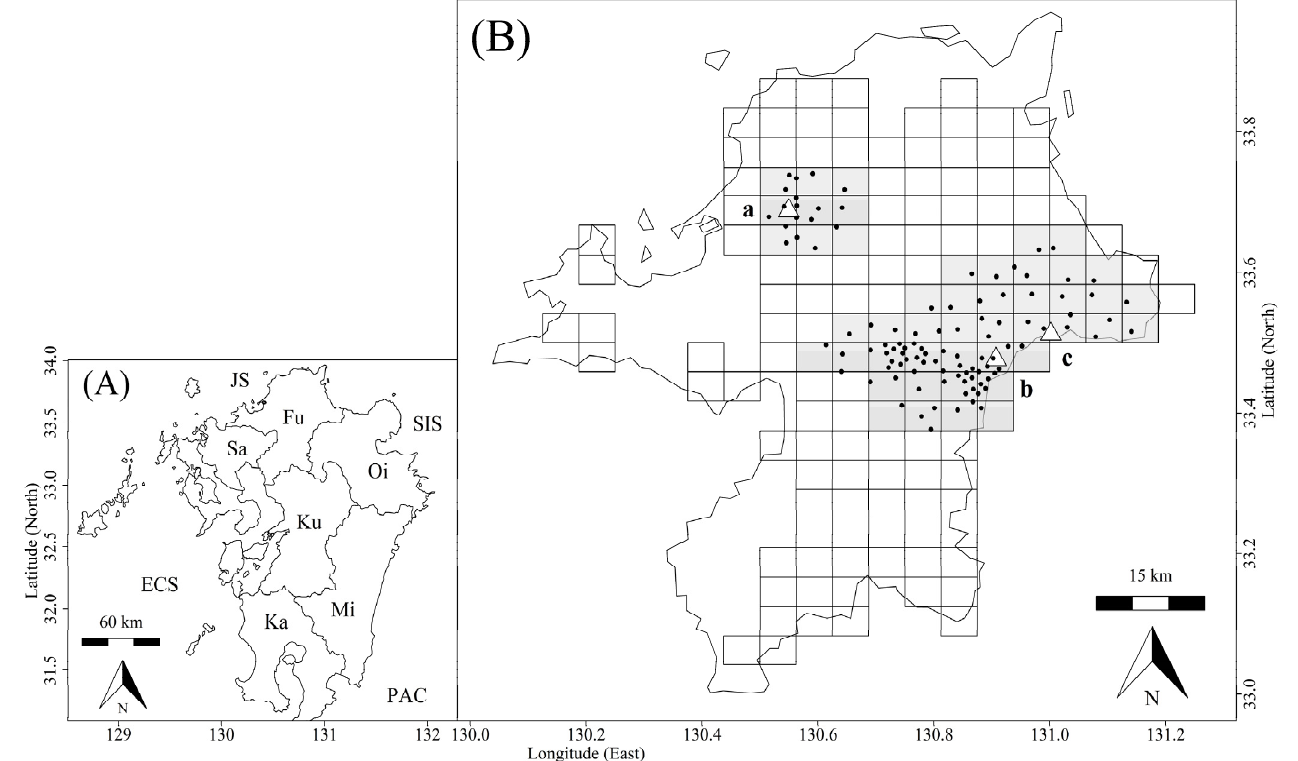
Figure 1. Map of Kyushu Island ( A ) and survey area in Fukuoka Prefecture ( B ). In map ( A ), Fu, Sa, Oi, Ku, Mi, and Ka indicate the Fukuoka, Saga, Oita, Kumamoto, Miyazaki, and Kagoshima prefectures, respectively. ECS, JS, and SIS indicate East China, Japan, and the Seto Inland Seas, respectively. PAC is the Pacific Ocean. In map ( B ), grids with sika deer culling (white) and with both culling and faecal pellet count survey (grey) in Fukuoka Prefecture, Japan. Plots indicate locations of faecal pellet count surveys. White triangles are locations of Mt. Inunaki-yama (a), Mt. Hiko-san (b), and Mt. Inugatake (c).